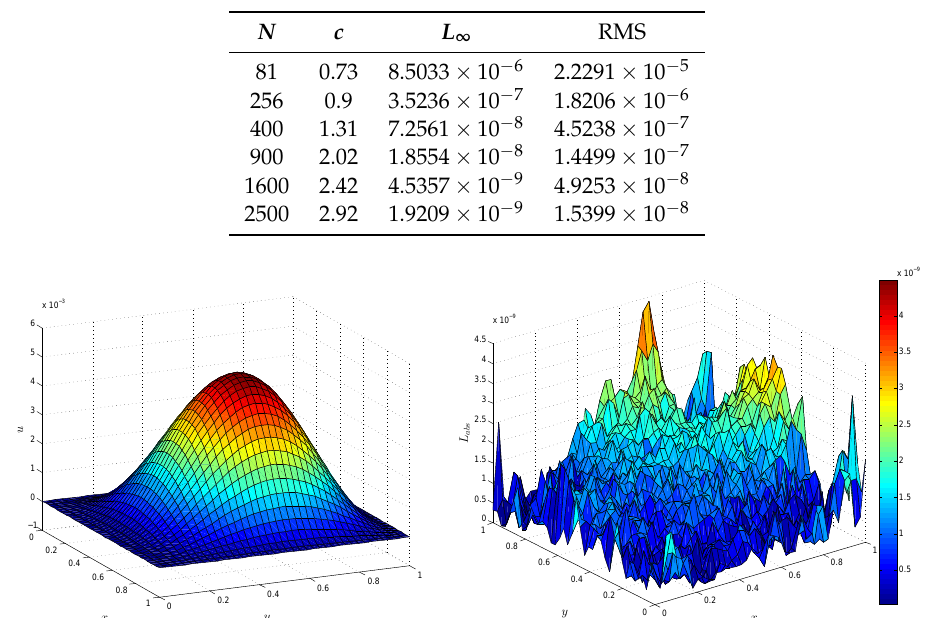
Table 4. Error norms for Problem 4.